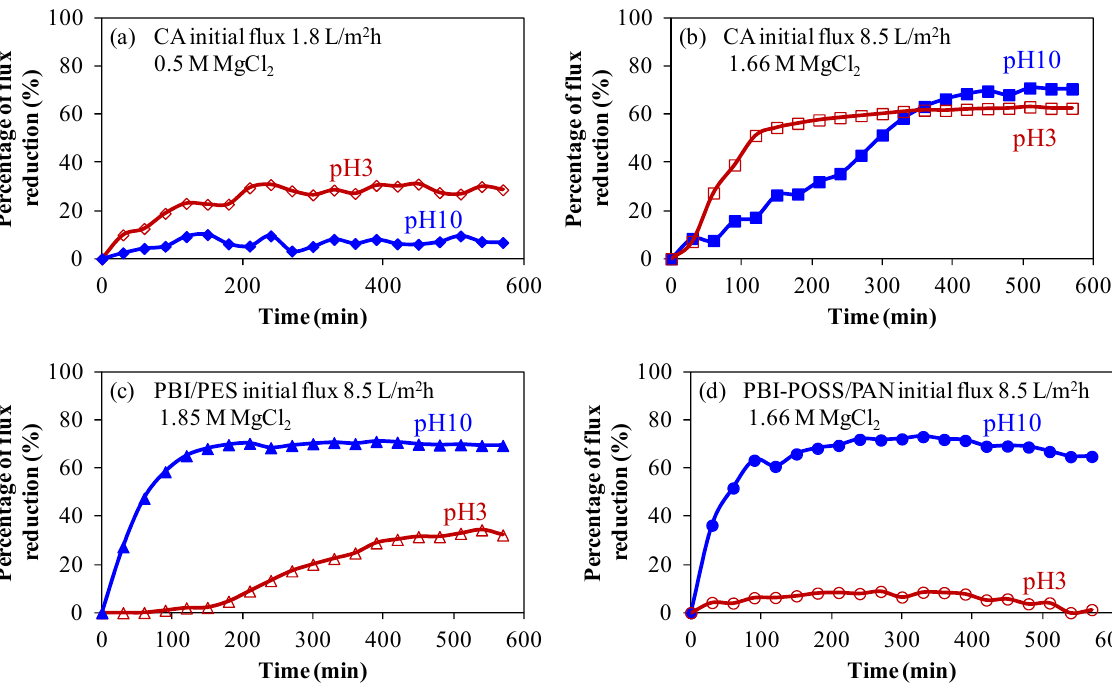
Figure 7. The pH effects on scaling for CA, PBI/PES and PBI-POSS/PAN membranes. CA membranes with various initial fluxes: ( a ) At a low initial flux of 1.8 L/m 2 h, the percentage of flux reduction is limited at pH 3 (29%) and pH 10 (8%); ( b ) at a high initial flux of 8.5 L/m 2 h, severe fouling occurs at pH 3 (63%) and pH 10 (71%). For PBI membranes with the same initial flux of 8.5 L/m 2 h, flux reduction on ( c ) annealed PBI/PES membranes is 69% at pH 10, but only 32% at pH 3; ( d ) annealed PBI-POSS/PAN is 65% at pH 10, but only 1.3% at pH